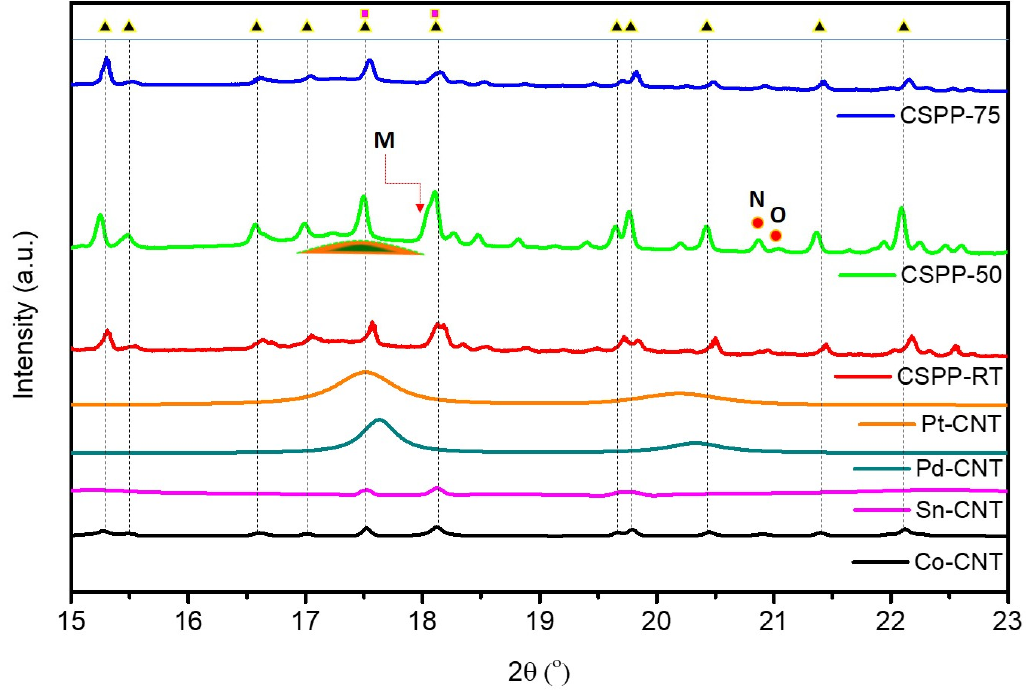
Figure 2. X-ray diffraction patterns of CNT supported CSPP NCs compared with reference samples (Co-CNT, Sn-CNT, Pd-CNT and Pt-CNT). All the spectra were measured under the incident X-ray of 18